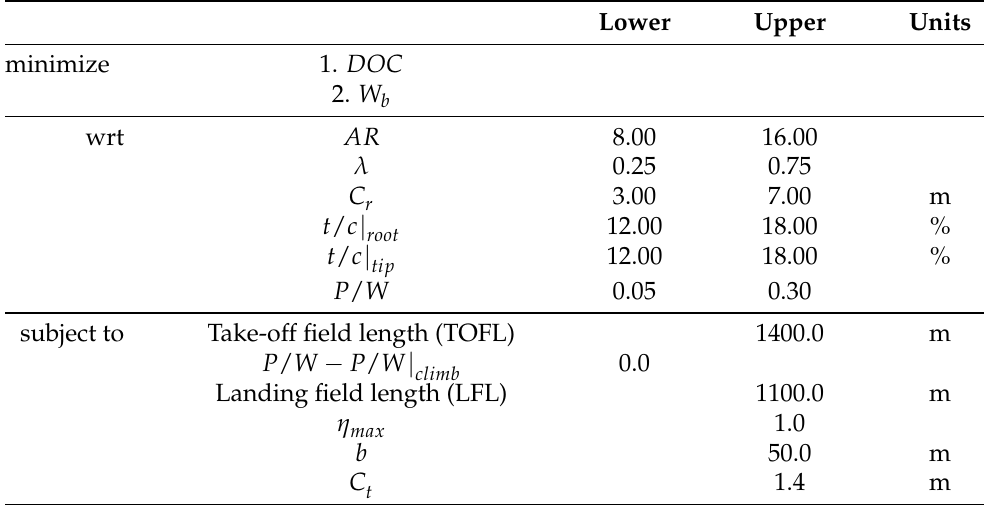
Table 5. SE 2 A SR aircraft optimization problem